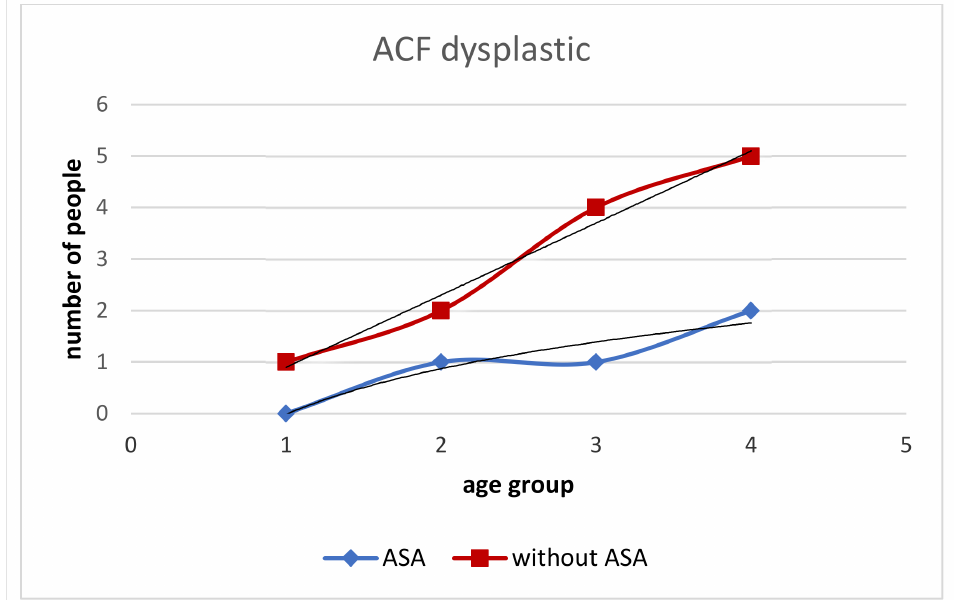
Figure 2. Incidence of dysplastic ACFs in the group with ASA and without ASA. The total number of dysplastic ACFs is higher in those without ASA. The increase in the number of dysplastic ACFs decreases with age in both groups (with ASA and without ASA), with the increase being greater in those without ASA.